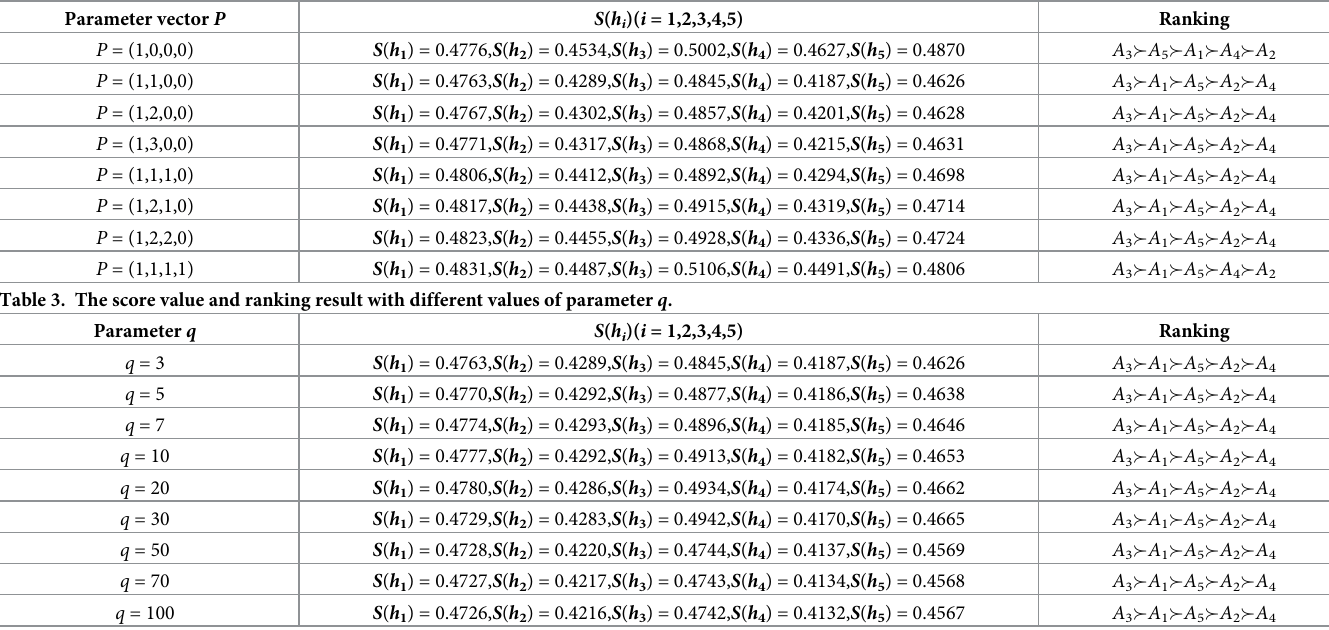
Table 3. The score value and ranking result with different values of parameter vector P .